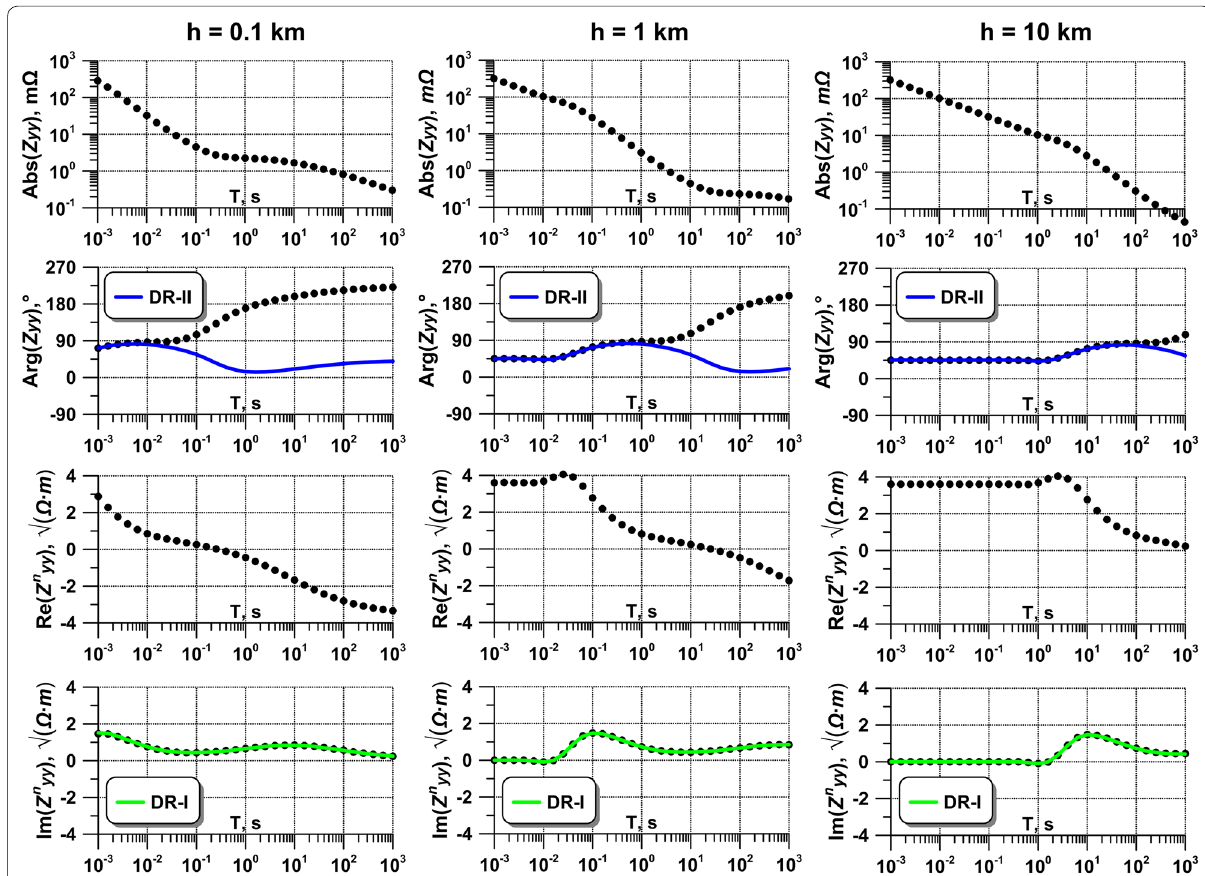
Fig. 2 The DR validity in the Z yy component (class 2) for various values of the upper layer’s thickness